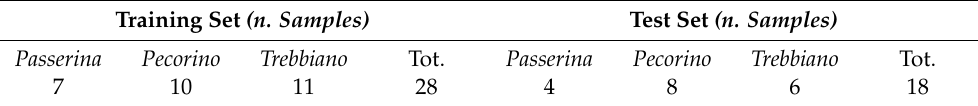
Table 1. Class memberships of the wine samples in the training and the test set. Training Set (n. Samples)